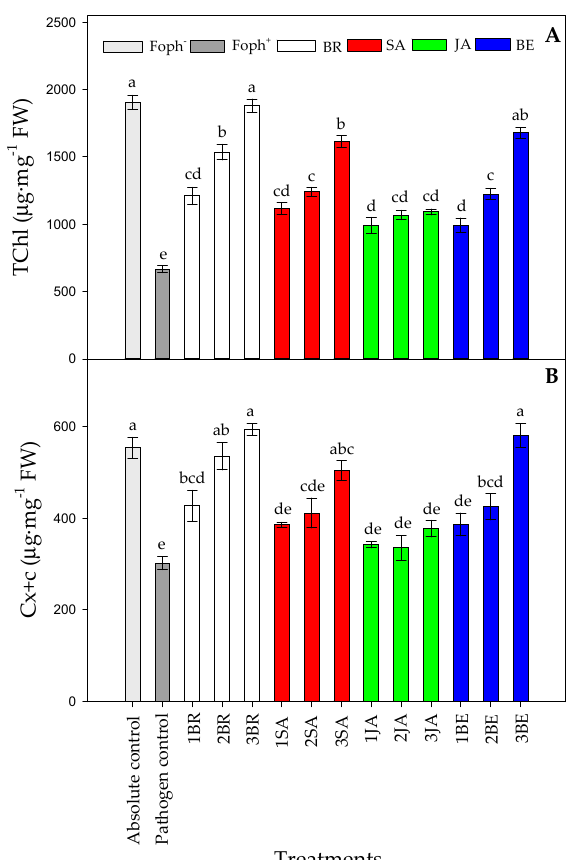
Figure 8. Effect of the different number of sprays (0, 1, 2 and 3 applications) of synthetic elicitors (Salicylic acid (SA), jasmonic acid (JA), Brassinosteroids (BR), or botanical extracts (BE)) on leaf total chlorophyll content ( A ) and leaf carotenoid contents ( B ) in Fusarium oxysporum f. sp. physali (Foph + ) infected cape gooseberry ( Physalis peruviana L.) plants at 50 DAI. Data represent the average of ten plants ±SE per treatment ( n = 10). Bars followed by different letters indicate statistically significant differences according to the Tukey test ( p ≤ 0.05).